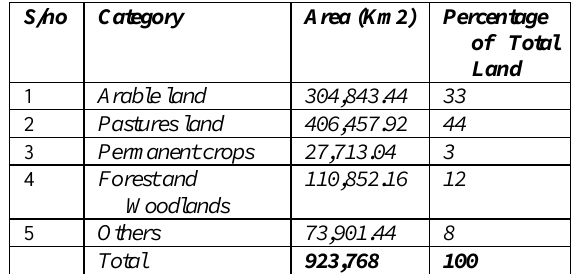
Table 1. Land usage category in Nigeria Nigerian, land administration system, is a very direct copy of (Queen) Her Majesty’s Land Registry in London